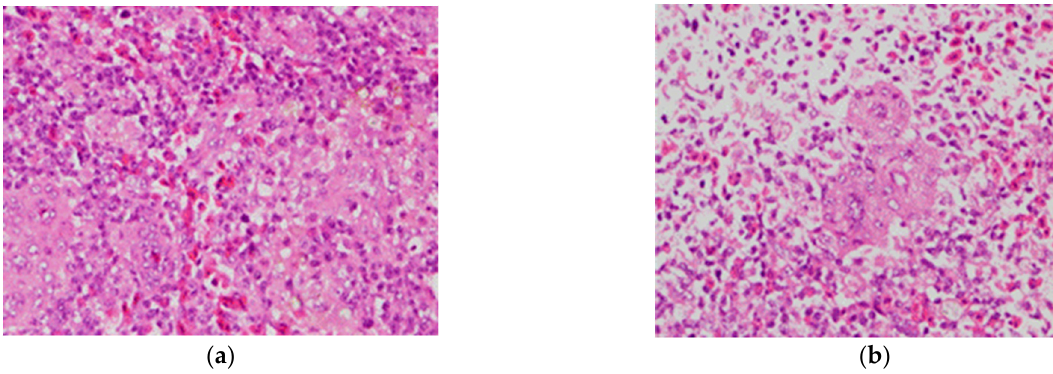
Figure 6. Histopathological examination of spleen samples. Spleen sample from challenged pigeons that were ( a ) immunized and ( b ) nonimmunized with PiCV rCap-VLPs. Spleen samples were stained with hematoxylin-eosin (H&E) stain and were observed under light microscope.